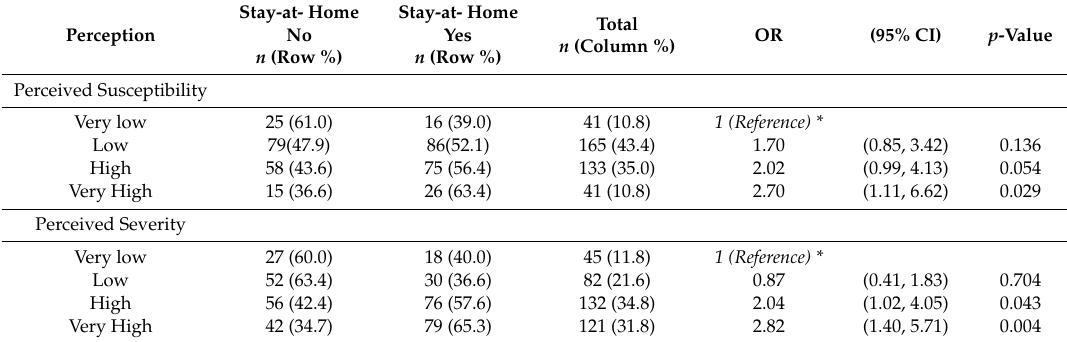
Table 4. Distribution and odds ratios of the preventive behavior “stay-at-home”, associated with the perception of becoming infected with Severe Acute Respiratory Syndrome Coronavirus 2 (SARS-CoV-2) and severity of the disease in adults ( ≥ 65 years old) in Mexico City.